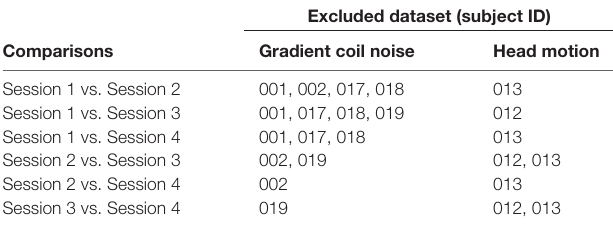
TABLE 2 | Participants’ data excluded in paired sample comparisons for the motion-corrected and scanner-noise-corrected dual regression analyses. Excluded dataset (subject